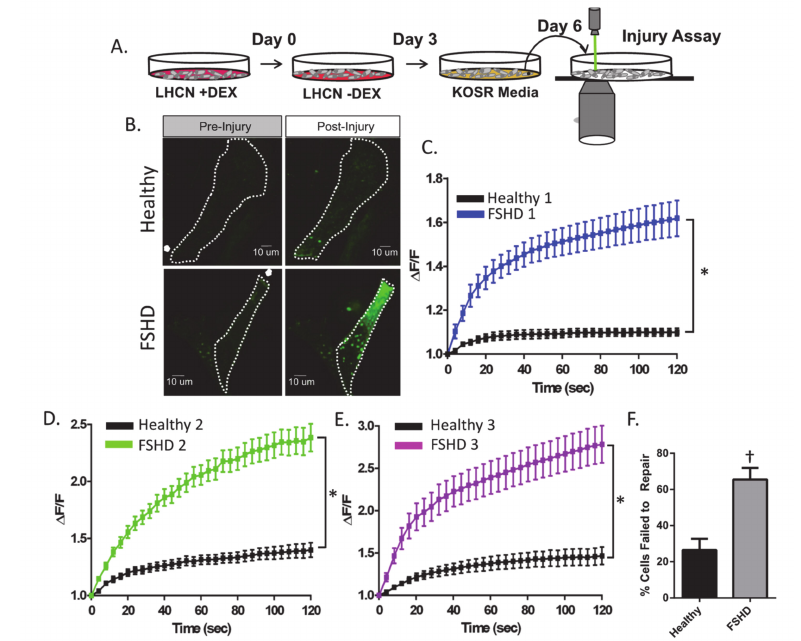
Figure 1. Immortalized myoblasts from individuals with Facioscapulohumeral Muscular Dystrophy (FSHD) display impaired membrane repair following laser ablation injury to the plasma membrane. ( A ) Outline of the cell culture protocol used in this study. Immortalized FSHD and una ff ected myoblasts were cultured and passaged in growth media with dexamethasone (LHCN + DEX). For all experiments, cells were seeded onto gelatin-coated coverslips in 6-well dishes and cultured in growth media without dexamethasone (LHCN –DEX) for three days. After three days, cells were transitioned to 15% knockout serum replacement media (KOSR media) for three days before laser injury assay. ( B ) Images of FM1-43 dye entry (green) in injured myoblasts at baseline (pre-injury) and at 120 s post-injury. Arrow indicates location of laser injury. Dotted line indicates cell outline. ( C – E ) Change in intracellular FM1-43 dye fluorescent intensity ( ∆ F / F) over time for FSHD myoblasts (FSHD1 n = 33 cells, FSHD2 n = 26 cells, FSHD3 n = 31 cells) and una ff ected control myoblasts (Healthy1 n = 30 cells, Healthy2 n = 24 cells, Healthy3 n = 31 cells) respectively. Greater dye entry indicates worse repair. ( F ) The percentage of healthy and FSHD cells that failed to repair. Values are mean ± SEM. * indicates significant genotype (FSHD vs. Healthy)*time interaction for FM1-43 intensity at p < 0.001. † denotes di ff erence between FSHD and healthy myoblasts, independent t -test, p <